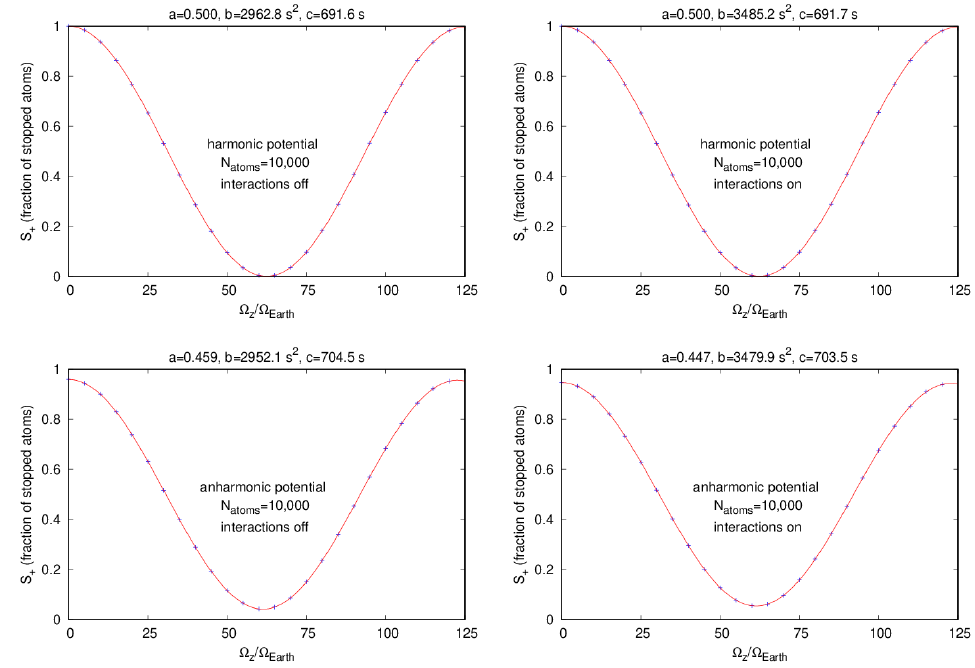
Figure 2. The fraction of stopped atoms, S + , vs. rotating frame speed, Ω z , with N atoms = 10,000 87 Rb atoms for four different cases. Upper Left : harmonic potential and cloud–cloud interactions off; Upper Right : harmonic potential and interactions on; Lower Left : anharmonic potential and interac- tions off; Lower Right : anharmonic potential and interactions